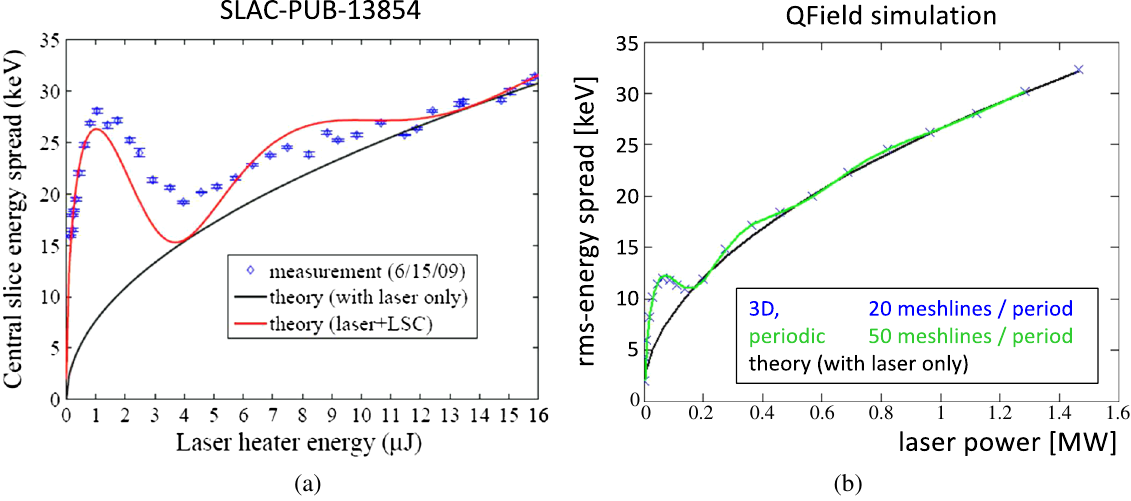
FIG. 24. Application C: (a) measurement with the 135 MeV spectrometer [10], (b) simulation with QField-periodic and QField-